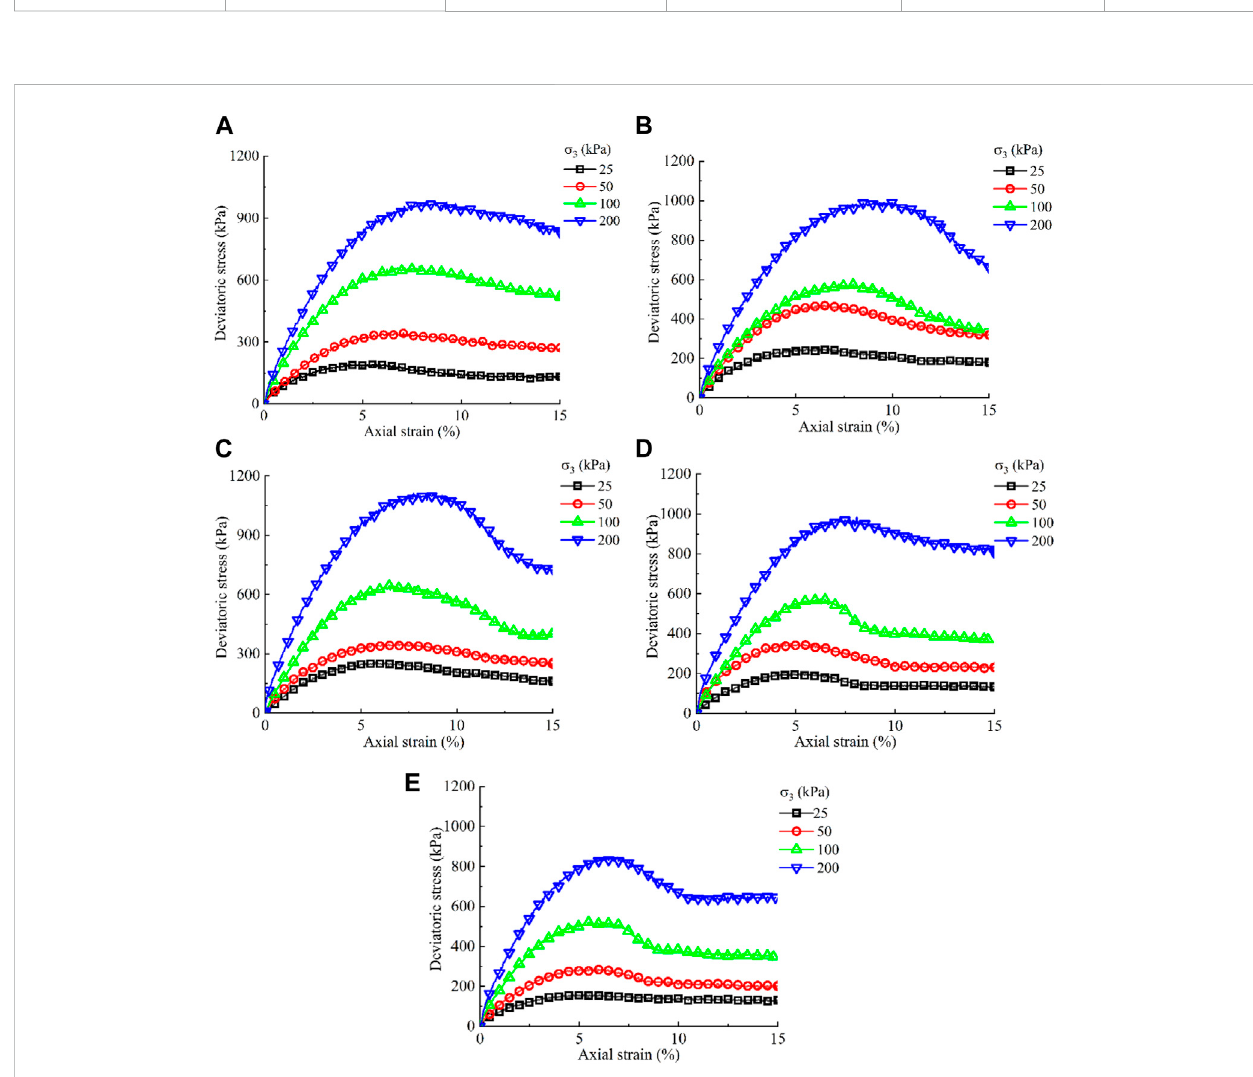
FIGURE 3 Deviatoricstress – axialstraincurves. (A) Calcareousgravelsand. (B) Calcareouscoarsesand. (C) Calcareousmedium sand. (D) Calcareous fi nesand. (E) Calcareous